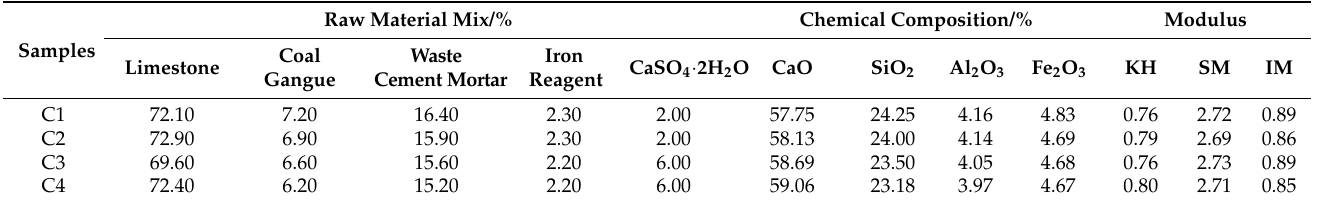
Table 4. The composition of raw meals with the addition of 2 and 6 wt.% GY in wt.% and expected basic chemical parameters.